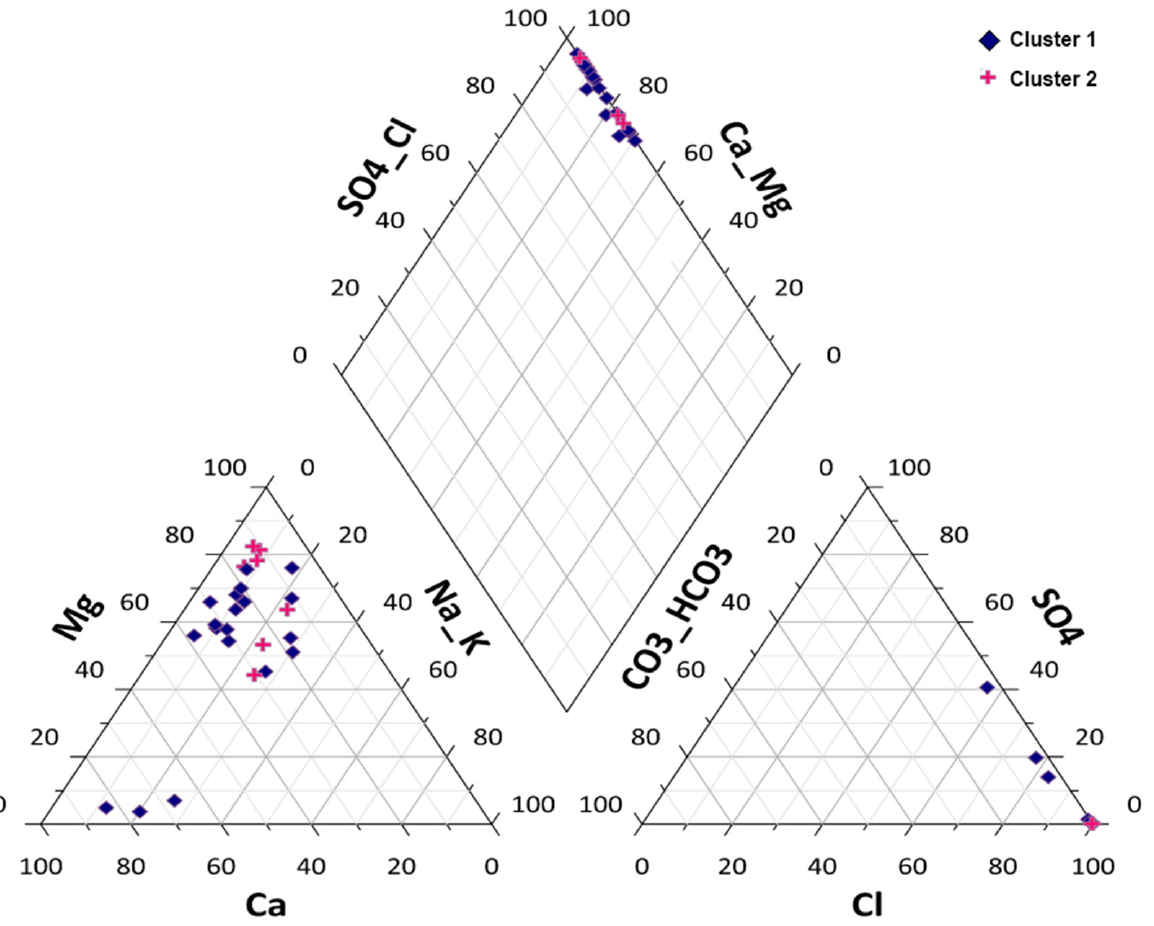
Figure 2. Irrigation water quality of estimated based on: Piper diagram.